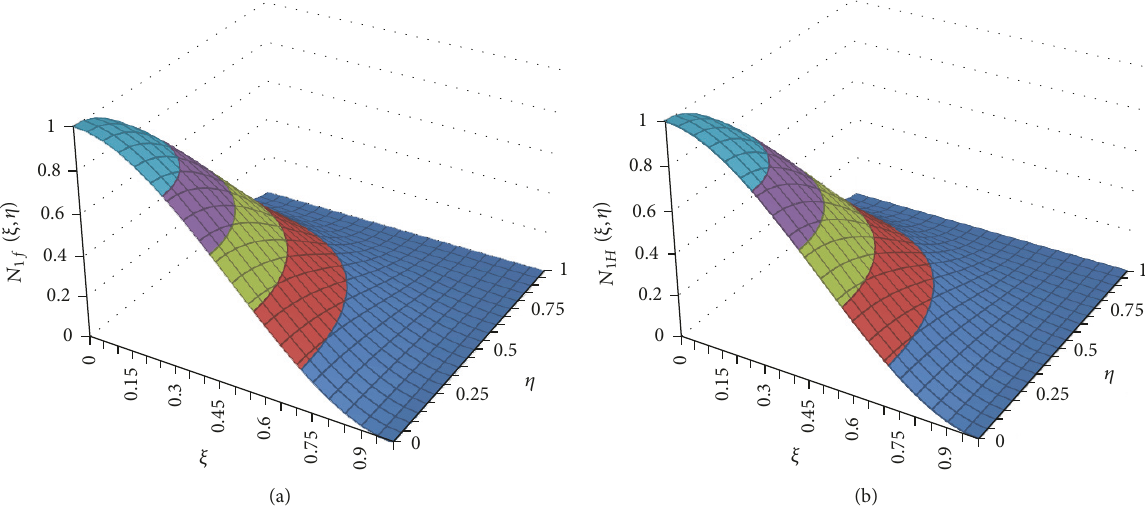
Figure 2: DFE (a) and FEM (b) shape function for 𝑤 1 at node 1.